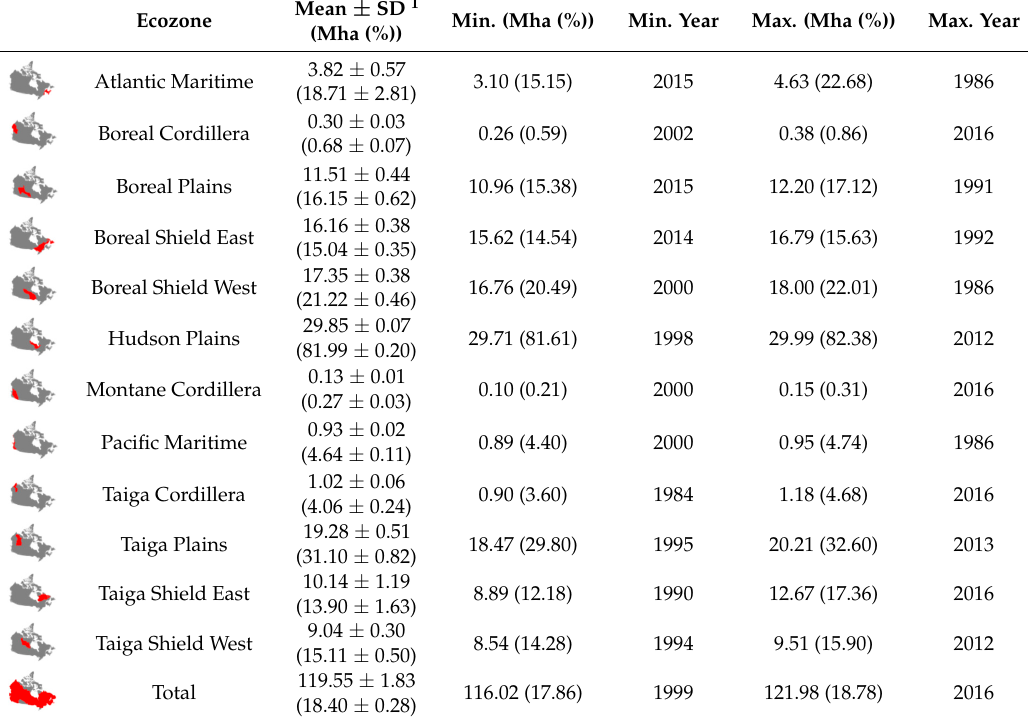
Table 1. Summary statistics of wetland area (millions of hectares, Mha), by ecozone, for the period, 1984–2016. Numbers in the parentheses are the percentage of an ecozone covered by wetlands.